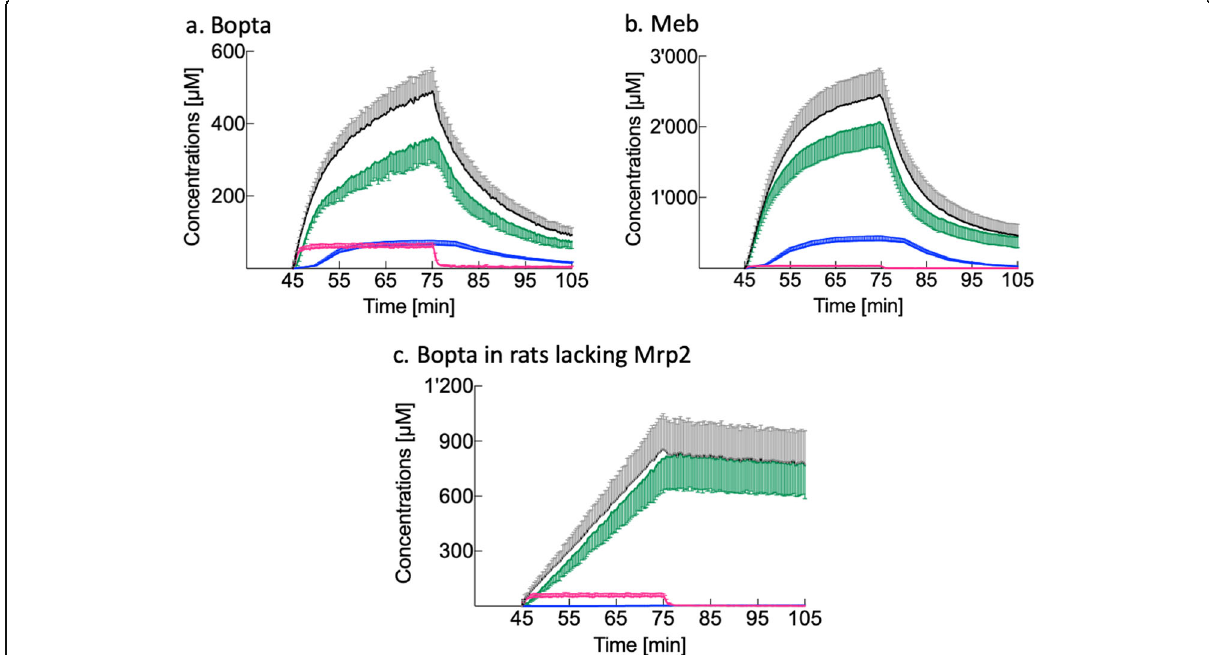
Fig. 2 Bopta and Meb compartmental distribution. a Normal livers ( n = 9) perfused with Krebs-Henseleit bicarbonate solution (KHB) + 200 μ M Bopta (45 – 75 min) and KHB (75 – 105 min). b Normal livers ( n = 9) perfused with KHB + 64 μ M Meb (45 – 75 min) and KHB (75 – 105 min). c Cholestatic livers lacking Mrp2 ( n = 6) perfused with KHB + 200 μ M Bopta (45 – 75 min) and KHB (75 – 105 min). Liver concentrations (black symbols) are measured by the counter. Concentrations in extracellular compartment (red symbols) are measured during the previous Dtpa perfusion (data not shown). Concentrations that originate from bile canaliculi (blue symbols) and from 78% hepatocytes (green symbols) are calculated ) below T had a slope of 0.001, Table 2). The first lines ( L 1 0 37 ± 5 μ M/min for Bopta and 333 ± 71 μ M/min for Meb ( p < 0.001). Thus, Meb entry into livers was much higher Bopta liver accumulation fitted a segmental linear regres- than Bopta entry. The second lines ( L sion, whilst Meb accumulation fitted a continuous hinge for time > T ) had 2 0 function (Fig. 3a, b, left panels). Both regressions were de- lower slopes (8 ± 1 μ M/min for Bopta and 16 ± 5 μ M/min scribed by two lines L for Meb, p < 0.001). After T and L intersecting at T or time , liver concentrations 1 2 0 0 when bile excretion started to impact the accumulation. A reflected the balance between uptake and excretory trans- gentle transition between the two lines characterised Meb (Fig. 3b, left panels, red fit), whilst Bopta transition was min after the perfusion start: 13,994 ± 2,391 μ M for Meb abrupt (Fig. 3a, left panel, red fit). T and 2,107 ± 710 μ M for Bopta ( p < 0.001). During the was slightly shorter 0 for Meb (5.5 ± 1.1 min) than Bopta (8.0 ± 0.5 min) ( p < Table 1 Bopta and Meb concentrations (end of accumulation period) Imaging agents Bopta Meb p , Bopta versus Meb Bopta Livers Normal Normal no Mrp2 C μ M] 200 64 200 in [ 185 ± 2